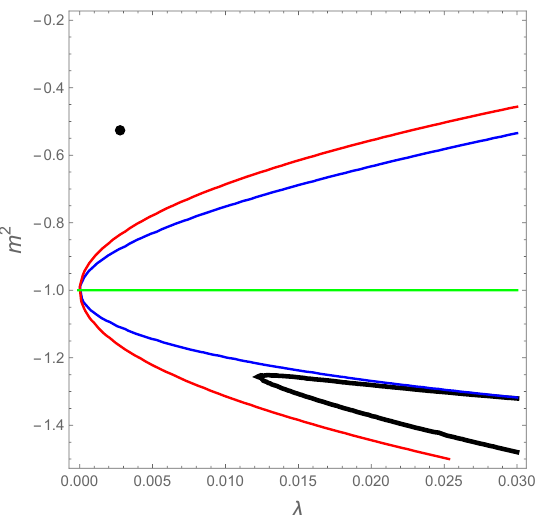
Figure 6. The relevant lines over the maximally-extended region I (cid:48) , bounded at the bottom with the singularity line m 2 = − 1 (in green). The blue and red curves correspond respectively to the equations L = 0 and Ω = 0. Moreover, the black point corresponds to the numerical non-Gaussian fixed point, so far from the two previous physical